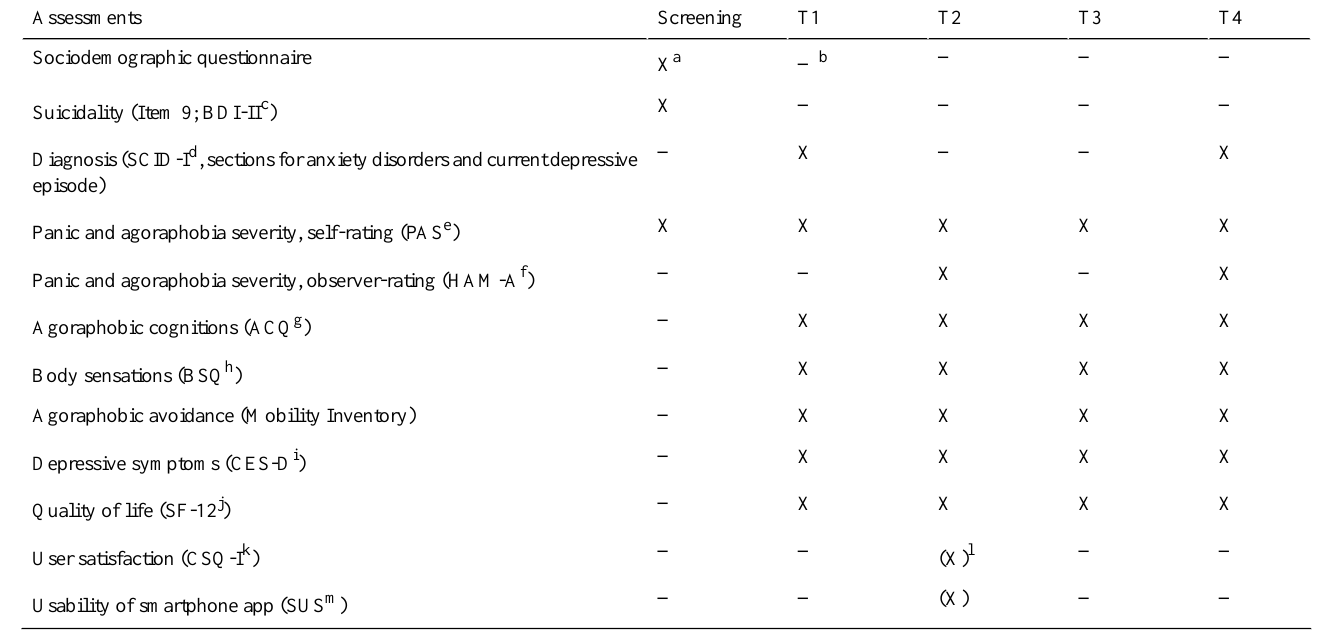
Table 2. Assessment schedule.